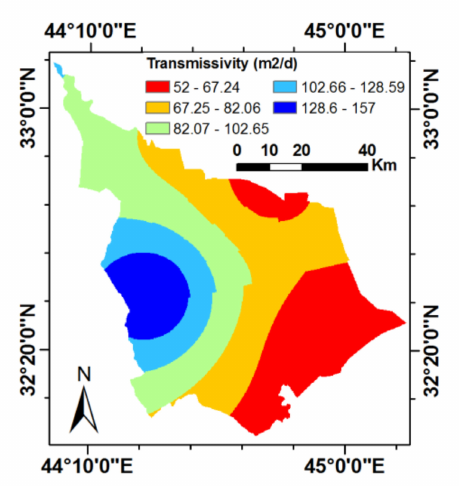
Figure 11. Transmissivity map for Babylon aquifer, modified after